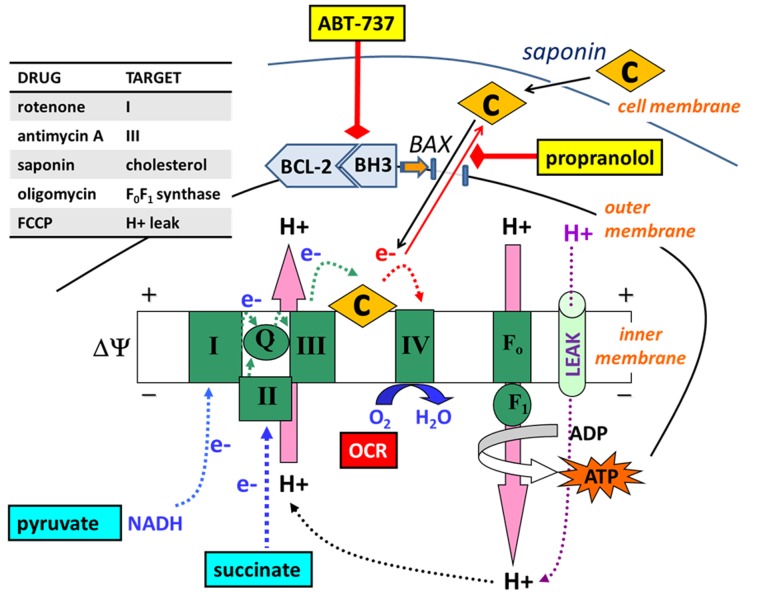
Bioenergetics-based profiling predicts BAX/BAK-dependent cytochrome c release.The schematic diagram and table (inset) outline drugs and drug targets used in the study. In bioenergetic-profiling assays, electrons are donated to the electron transport chain via complex I or complex II substrate (pyruvate or succinate, respectively). Cyt c (C), normally present in excess, is required to transfer electrons from complex III to complex IV. ABT-737 (or ABT-263) disrupts the binding of BCL-2 to BH3-only proteins (BH3) such as BIM on the mitochondrial outer membrane, enabling BAX/BAK activation, pore formation, and consequent cyt c release. The depletion of mitochondrial cyt c causes respiratory inhibition under conditions of high electron transport, such as in the presence of the uncoupler FCCP (Fig. 3–4,7) or a high ADP/ATP ratio (Fig. 5–6). Saponin permeabilizes the plasma membrane by extracting cholesterol, enabling the introduction of exogenous purified cyt c, which reverses respiratory inhibition due to cyt c release (Fig. 5). Propranolol, an inhibitor of BAX-induced cyt c release, delays the ABT-737-mediated loss of respiration (Fig. 6).